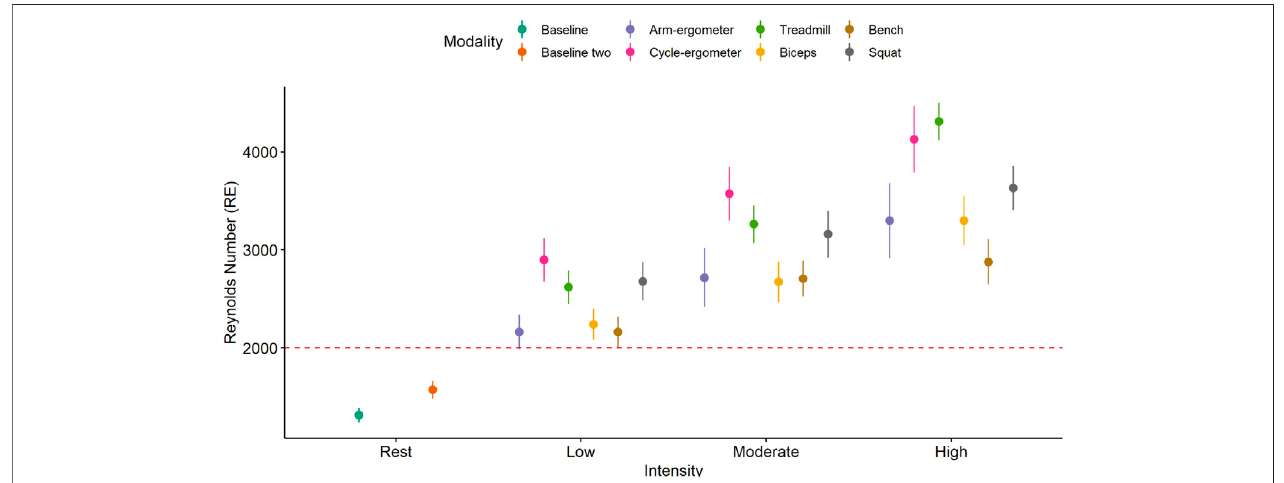
FIGURE 5 | Mean and 95% CI of Reynolds number (Re) by exercise modality and intensity with a turbulent fl ow threshold number of 2,000 (red dash